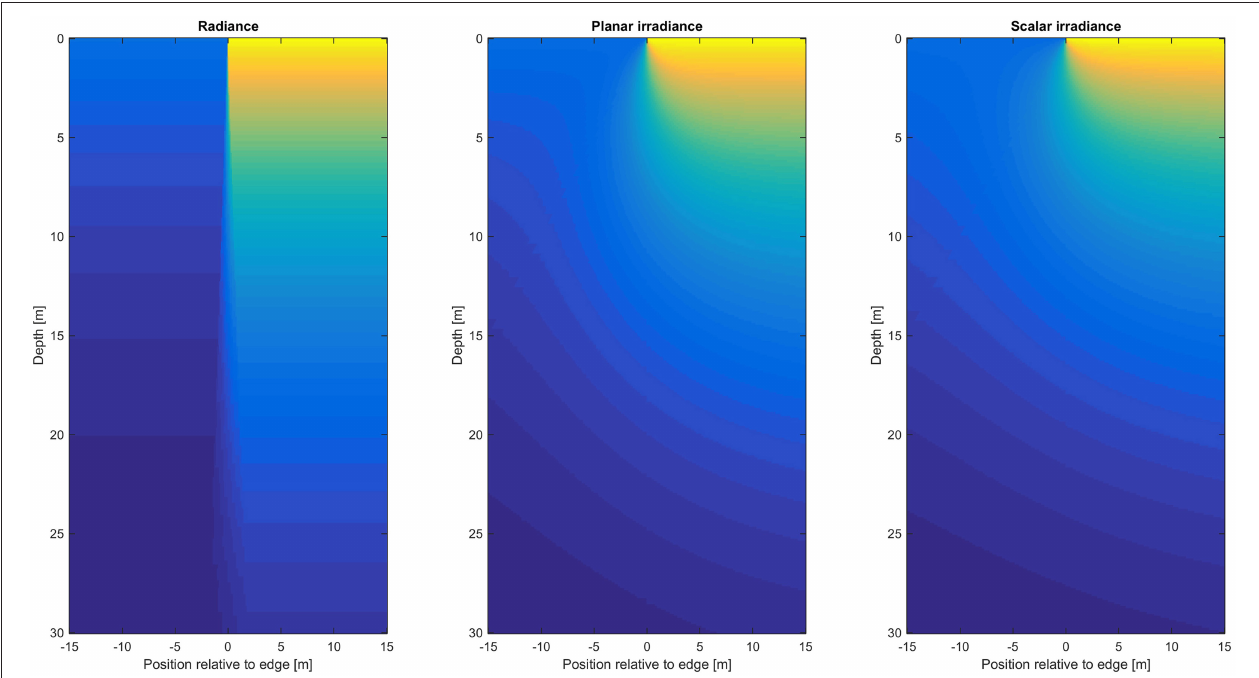
FIGURE 3 | Under ice light transmittance across a semi-infinite boundary measured with radiance (left), planar irradiance (middle), and scalar irradiance (right) sensors. Colors represent normalized light measurements from bright (yellow) to dark (blue). The scenario uses ice transmittances of 0.22 (right of the edge) and 0.04 (left of the edge) and a depth independent water extinction coefficient of κ = 0.1 m − 1